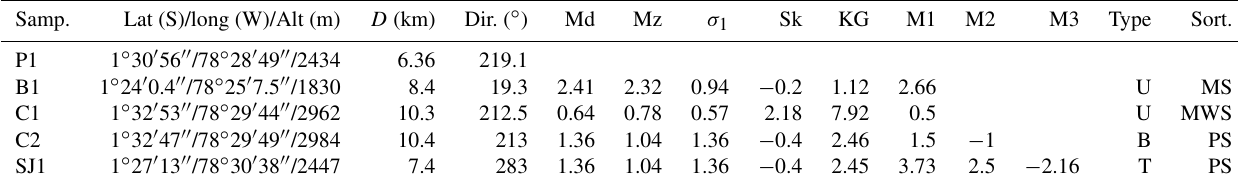
Table 3. Grain-size parameters for the tephra samples. Samp.